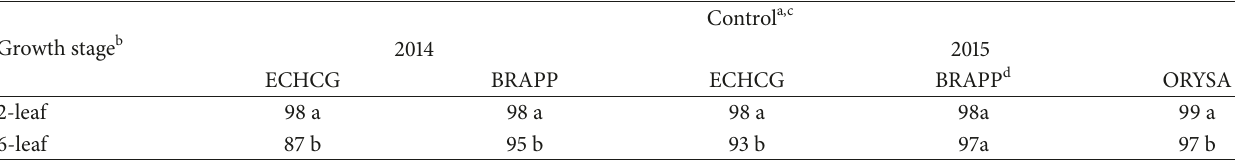
Table 4: Effect of grass growth stage at time of first quizalofop application on barnyardgrass, broadleaf signalgrass, and red rice control in 2014 and 2015 at Stuttgart,